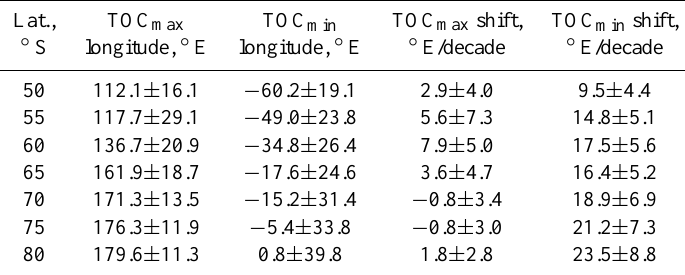
Table 2. Mean spring longitudes of the zonal wave maximum and minimum (TOC max and TOC min , respectively) and their decadal changes in the period 1979–2005. One standard deviation is given.